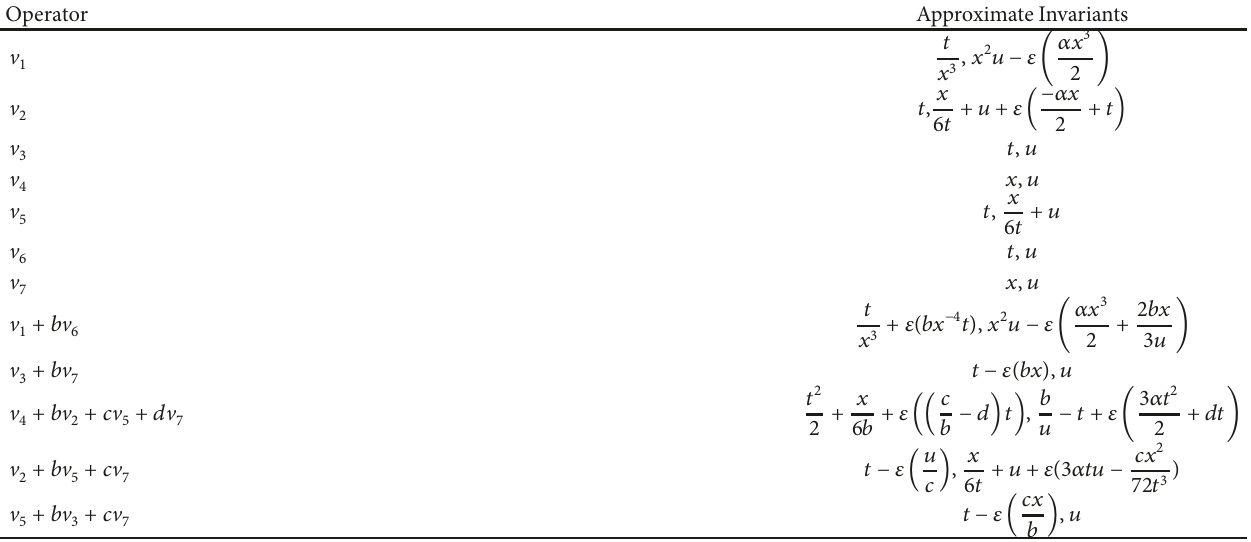
Table 5: Approximate invariants with respect to the generators of Lie algebra and optimal